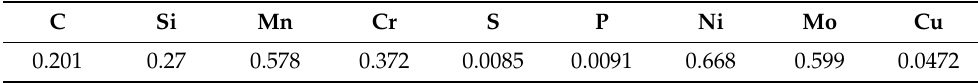
Table 2. A508 Cl.2 base metal chemical composition (wt %) of